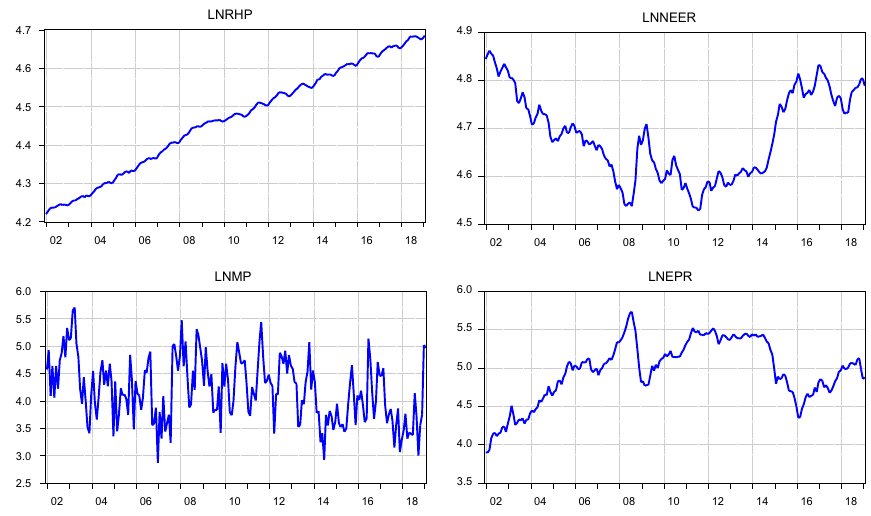
Fig. 1 Time series plot of variables for the